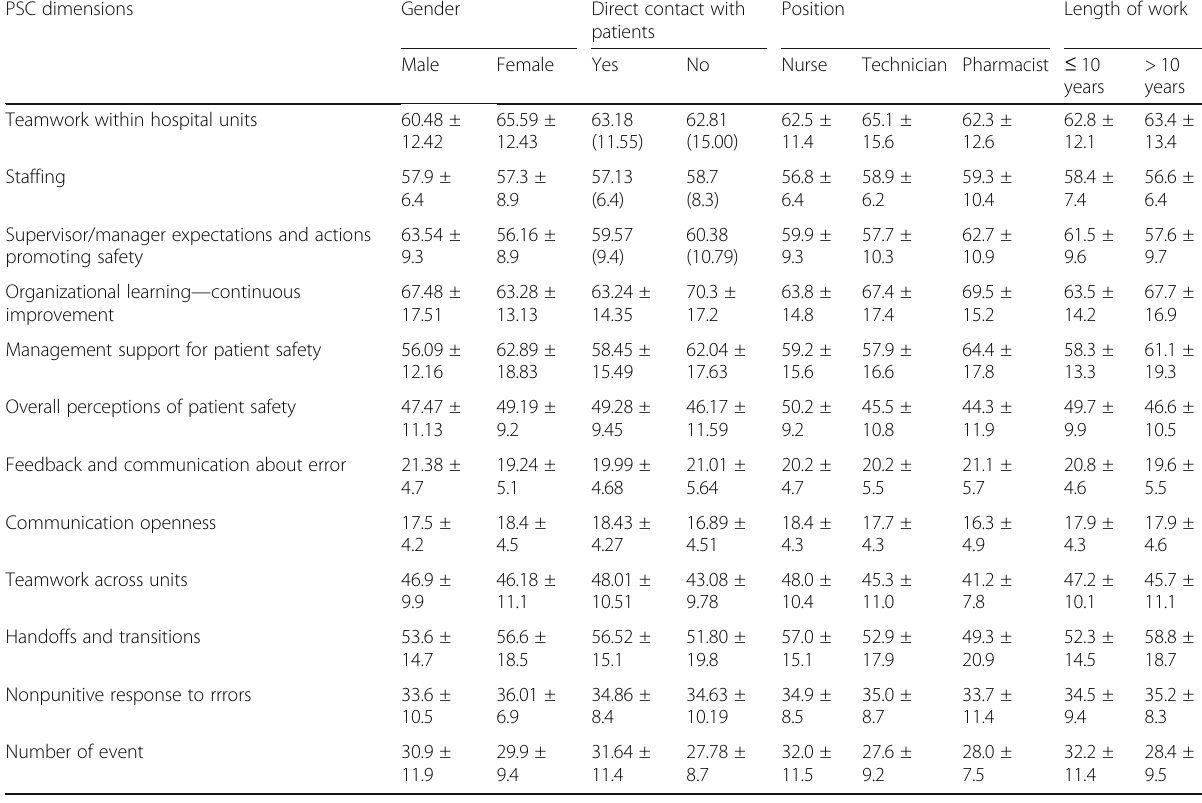
Table 3 Mean scores of patient safety culture dimensions according to demographic characteristics PSC